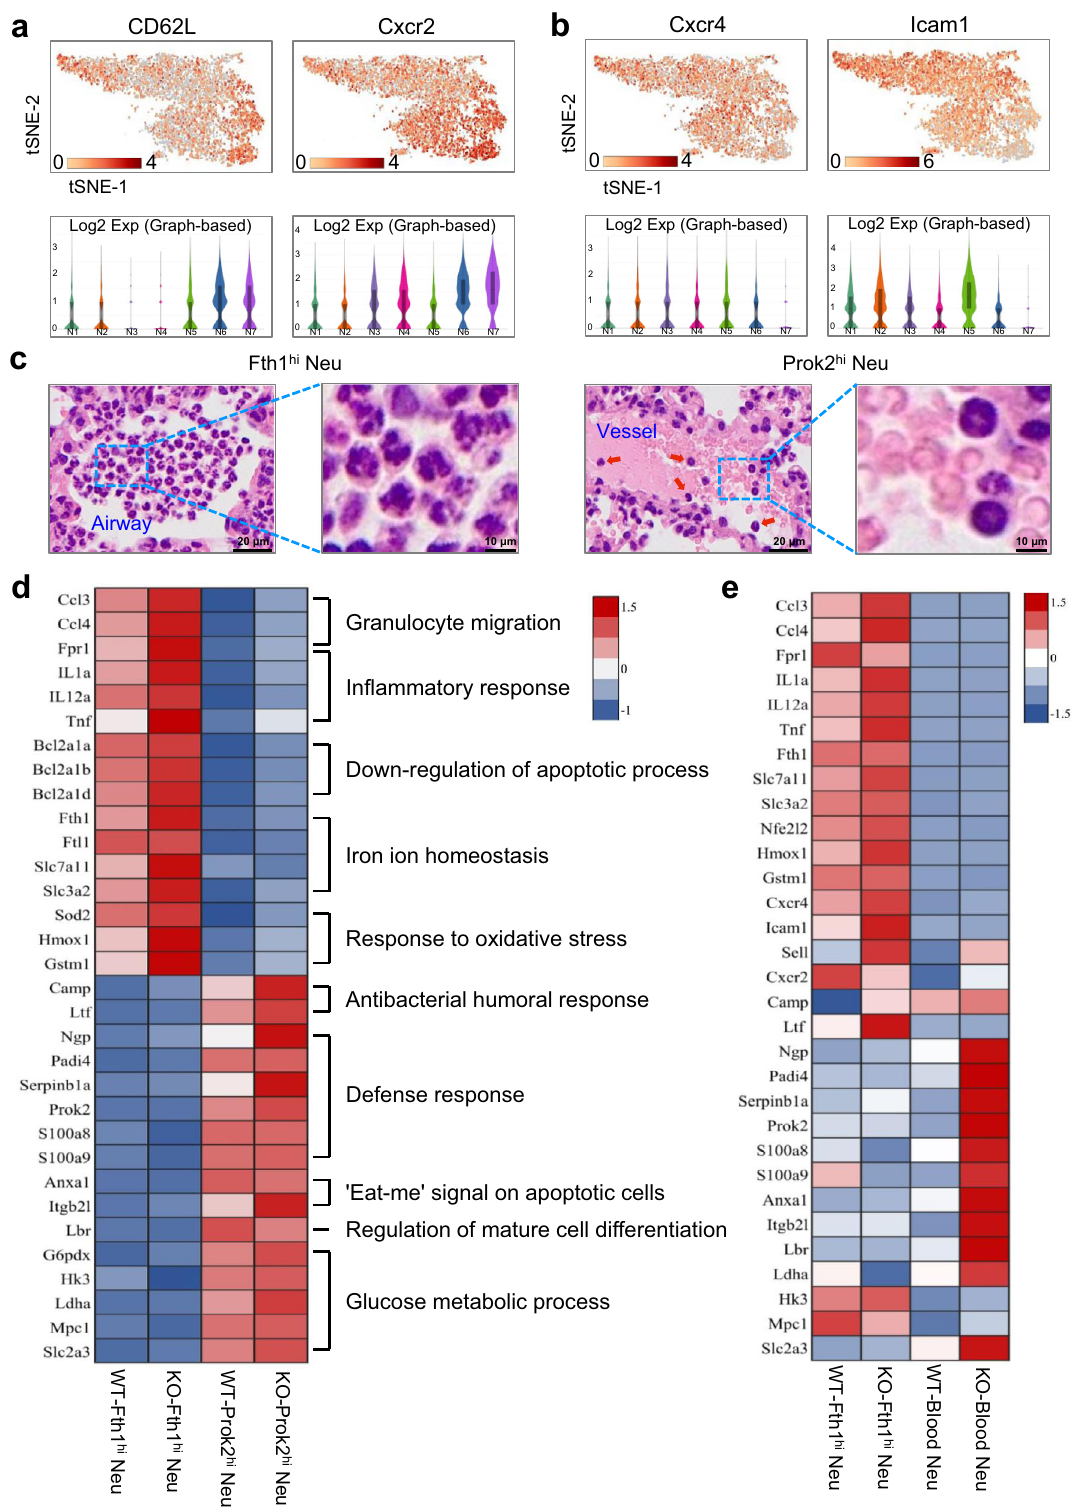
Fig.5|Functionalandmorphologicalheterogeneityoftwoneutrophilsubsets in ALI lungs. a , b The gene expression pro fi les projected onto t-SNE plots and corresponding violin plots for CD62L, Cxcr2, Cxcr4 and Icam1 (scale: log- transformed gene expression). Boxes within violin plot show the median±1 quar- tile, with the whiskers extending from the hinge to the smallest or largest value within 1.5× interquartile range from the box boundaries. n =1657, 1601, 1067, 953, 836, 572, 501 for N1-N7. c Representative micrographs of H&E-stained Fth1 hi and